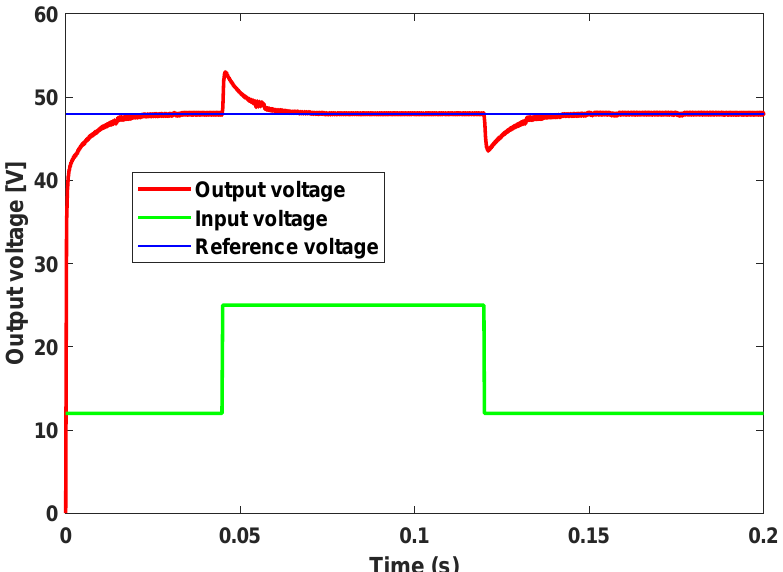
Figure 10. The dynamic response of SMC in the output voltage under an input voltage step change.